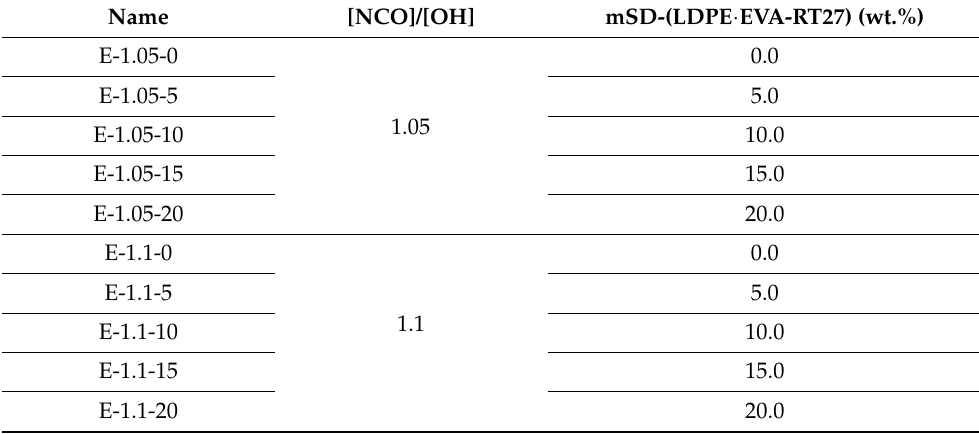
Table 1. [NCO]/[OH] molar ratios and mSD-(LDPE · EVA-RT27) contents of the synthesized